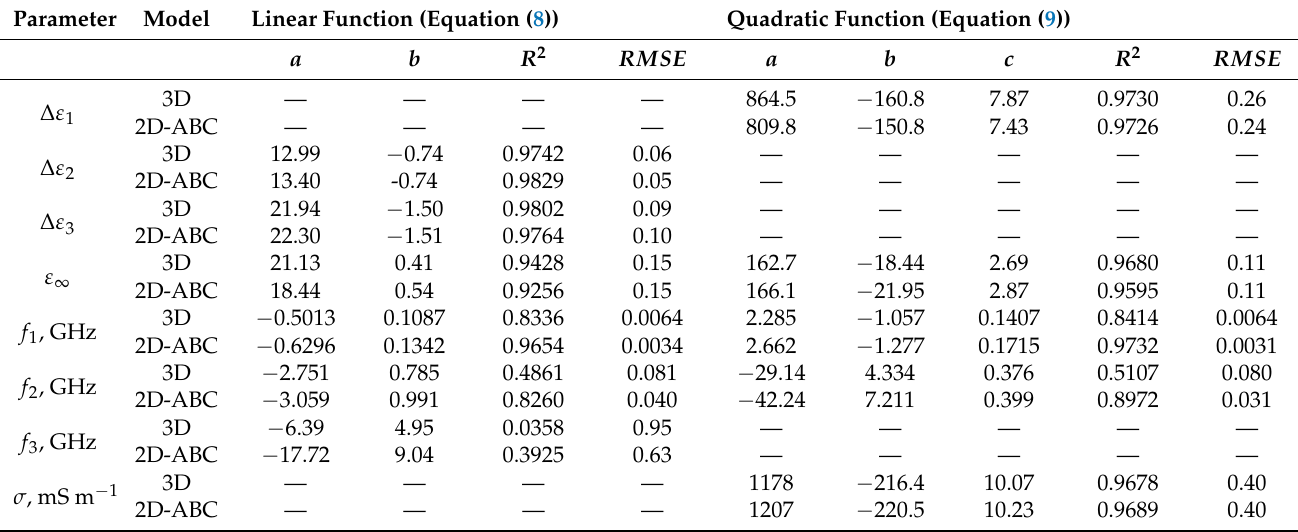
Table 3. Relations between 3D and 2D-ABC dielectric models’ parameters and moisture content, modeled by Equations (8) and (9), where appropriate. For each fitted equation, the coefficient of determination R 2 and root-mean-squared error RMSE are given.